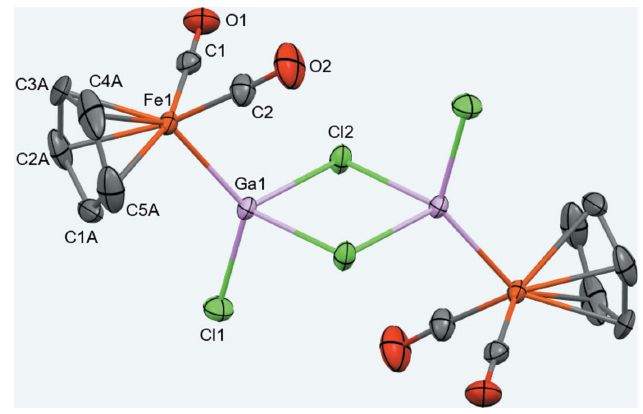
Figure 1 The title compound with 50% displacement ellipsoids. The H atoms and the minor occupied sites of the disordered atoms have been omitted for clarity. Unlabeled atoms are generated by an inversion